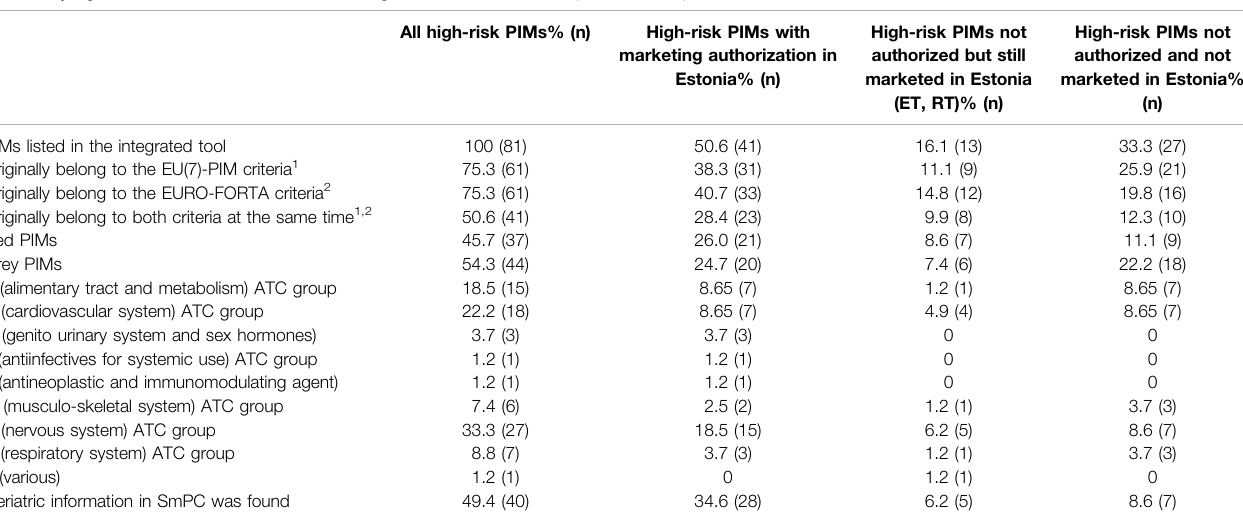
High-risk PIMs not High-risk PIMs not marketing authorization in authorized but still authorized and not Estonia% (n) marketed in Estonia marketed in Estonia% (ET, RT)% (n) (n)